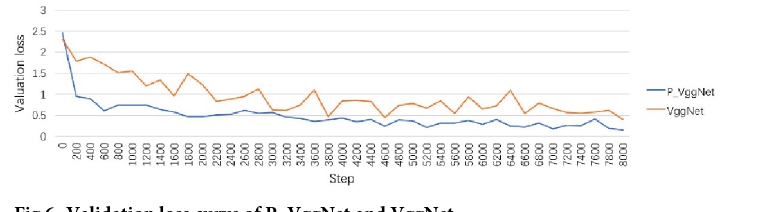
Fig 6. Validation loss curve of P_VggNet and VggNet.